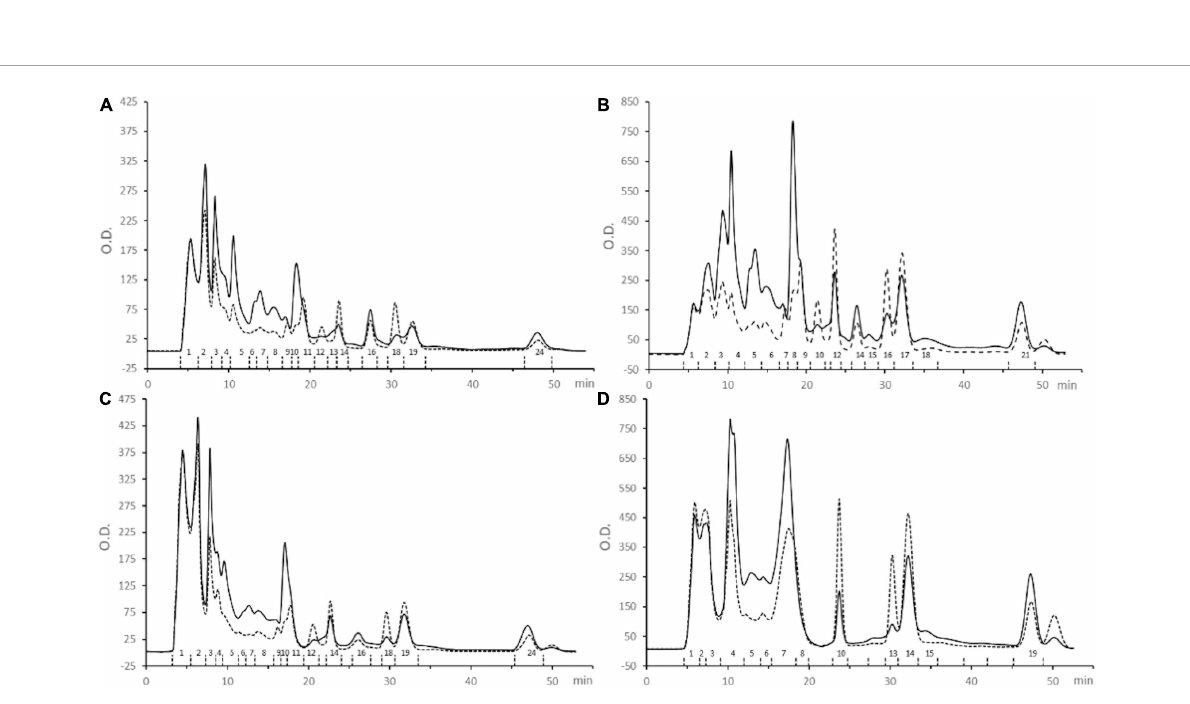
FIGURE4 Sub-fractionation of samples (A) Alcalase R1, (B) Alcalase P1, (C) Protamex R1, and (D) Protamex P1, by FPLC size exclusion chromatography. Sub-fractions are indicated by numbers. Continuous line: absorbance at 280 nm; dashed line: absorbance at 254